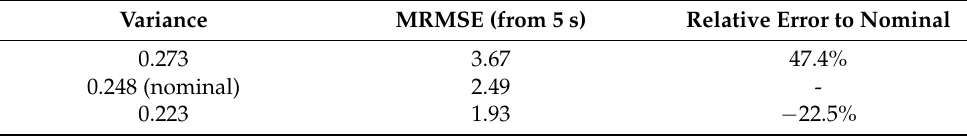
Table 5. Comparison of MRMSE for different Gaussian random